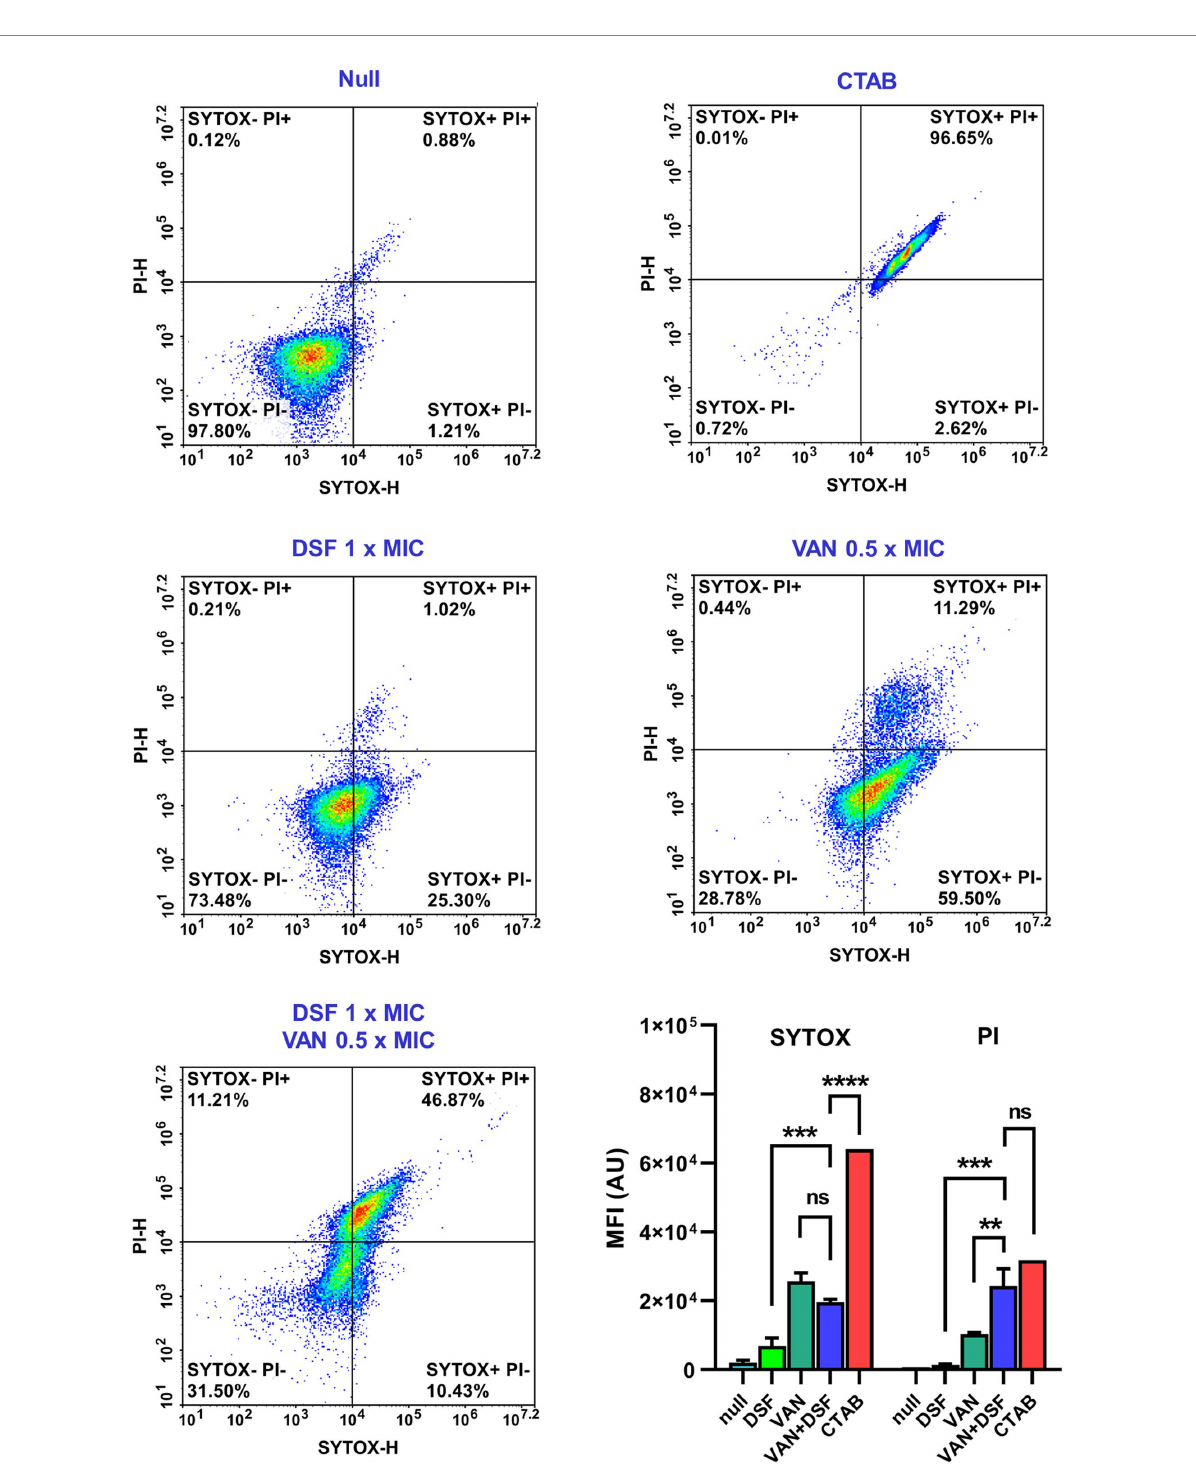
FIGURE 2 Flow cytometry viability analysis of Mu50 cells stained with SYTOX Green and propidium iodide (PI). Reference plots of bacteria treated with vehicle (null) and detergent (CTAB) were used to distinguish populations of viable (top left) and nonviable (top right) cells. Bar graphs depict the mean fluorescence intensity (MFI) and statistical significance depicted with asterisks (ns = p > 0.05; ** p ≤ 0.01; *** p ≤ 0.001; **** p ≤